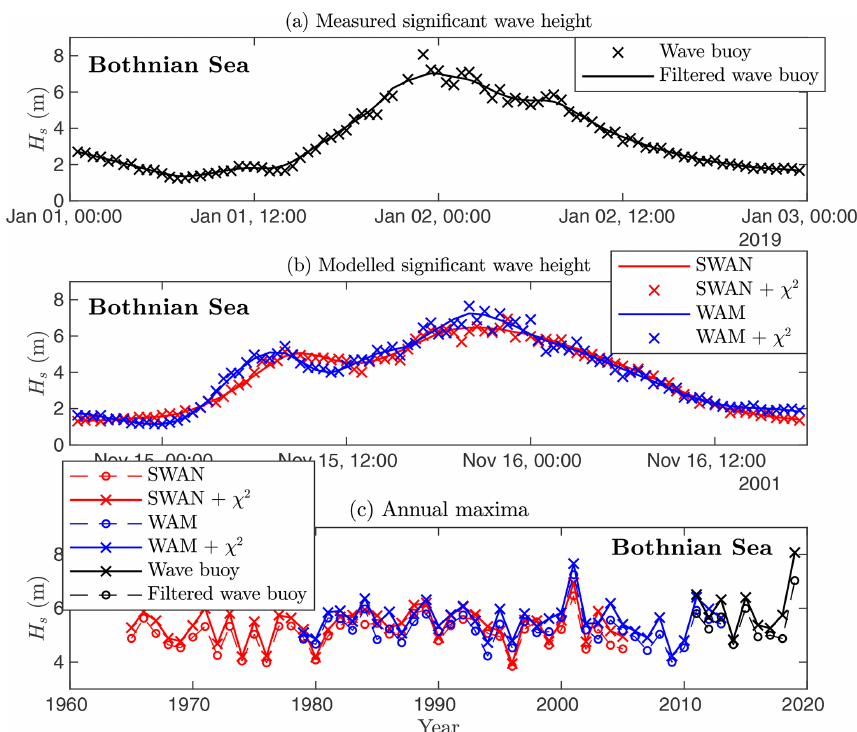
Figure 3. Short-term variability removed from observations through low-pass filtering (a) . Artificial χ 2 -distributed samples added to the wave model data from the most severe storm in the hindcasts (b) . In both instances annual maxima increase when calculated from data with variability (c) . Table 1. The four different 55-year time series. First, either the SWAN or the WAM hindcast was used as the primary source of model data. Second, two alternative methods to account for the difference in sampling variability between observations and model data were applied